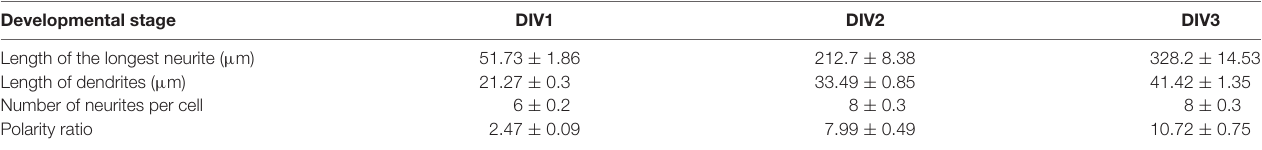
TABLE 1 | Developmental profile of primary cultures of rat hippocampal neurons. Developmental